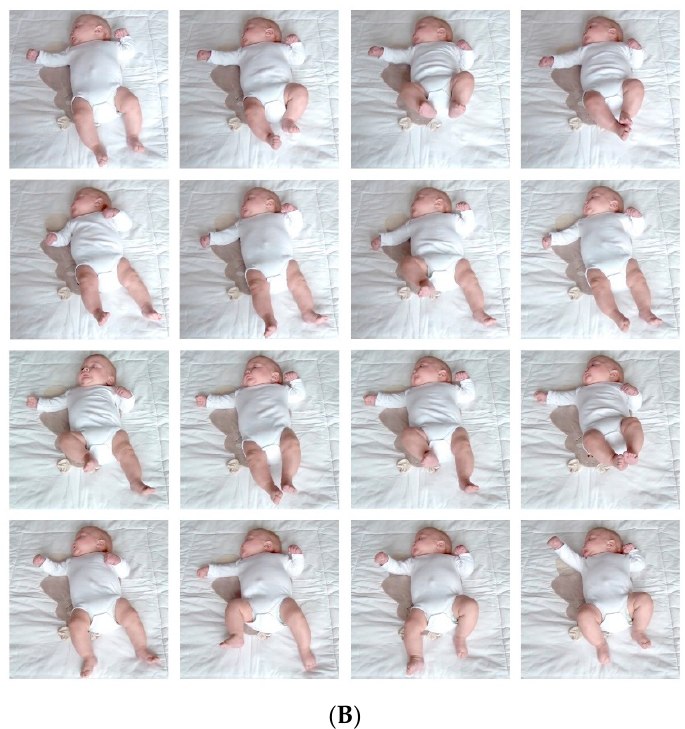
Figure 2. ( A ). Typical general movements characterized by movement complexity and variation in a 3-month-old infant. ( B ). Atypical general movements characterized by marked reduction in movement complexity and variation in a 3-months-old infant later diagnosed with bilateral spastic cerebral palsy (CP). Both subfigures consist of frames sampled from a video-recording of about 2 min. Figures produced with permission of the parents.